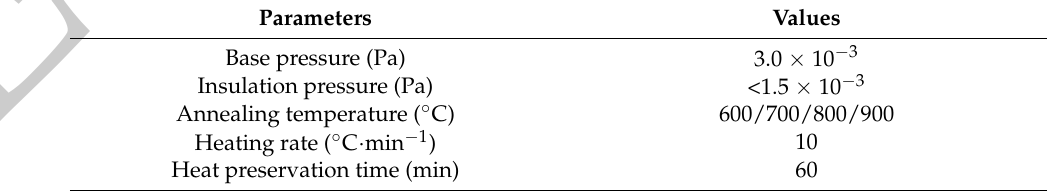
Table 2. Vacuum annealing parameters of the AlCrTiSiN